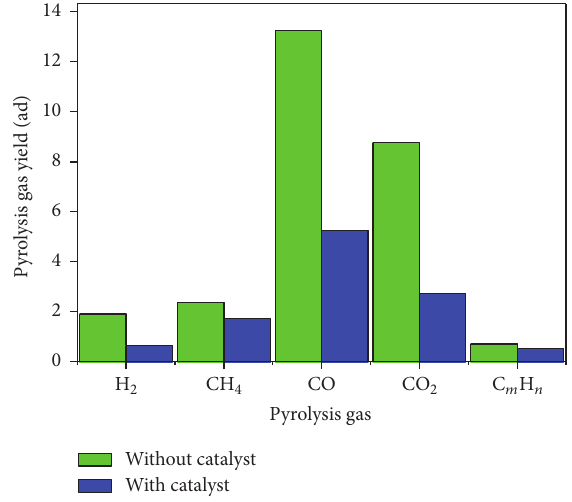
Figure 5: Gas components without and with